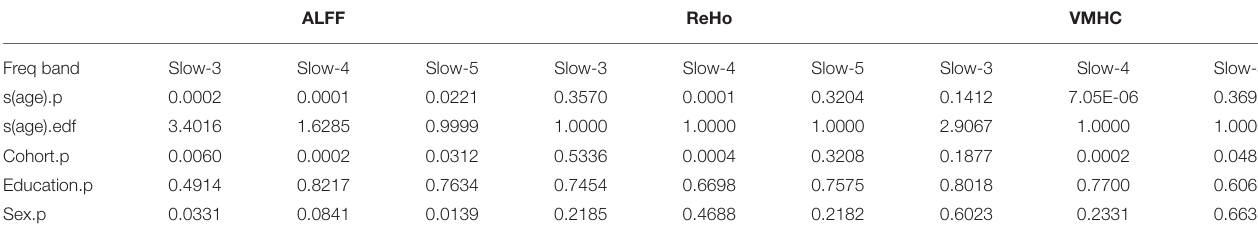
TABLE 2 | Generalized additive mixed models (GAMMs) on aging curve models for global variability measurements of CSA. ALFF ReHo VMHC Freq band Slow-3 Slow-4 Slow-5 Slow-3 Slow-4 Slow-5 Slow-3 Slow-4